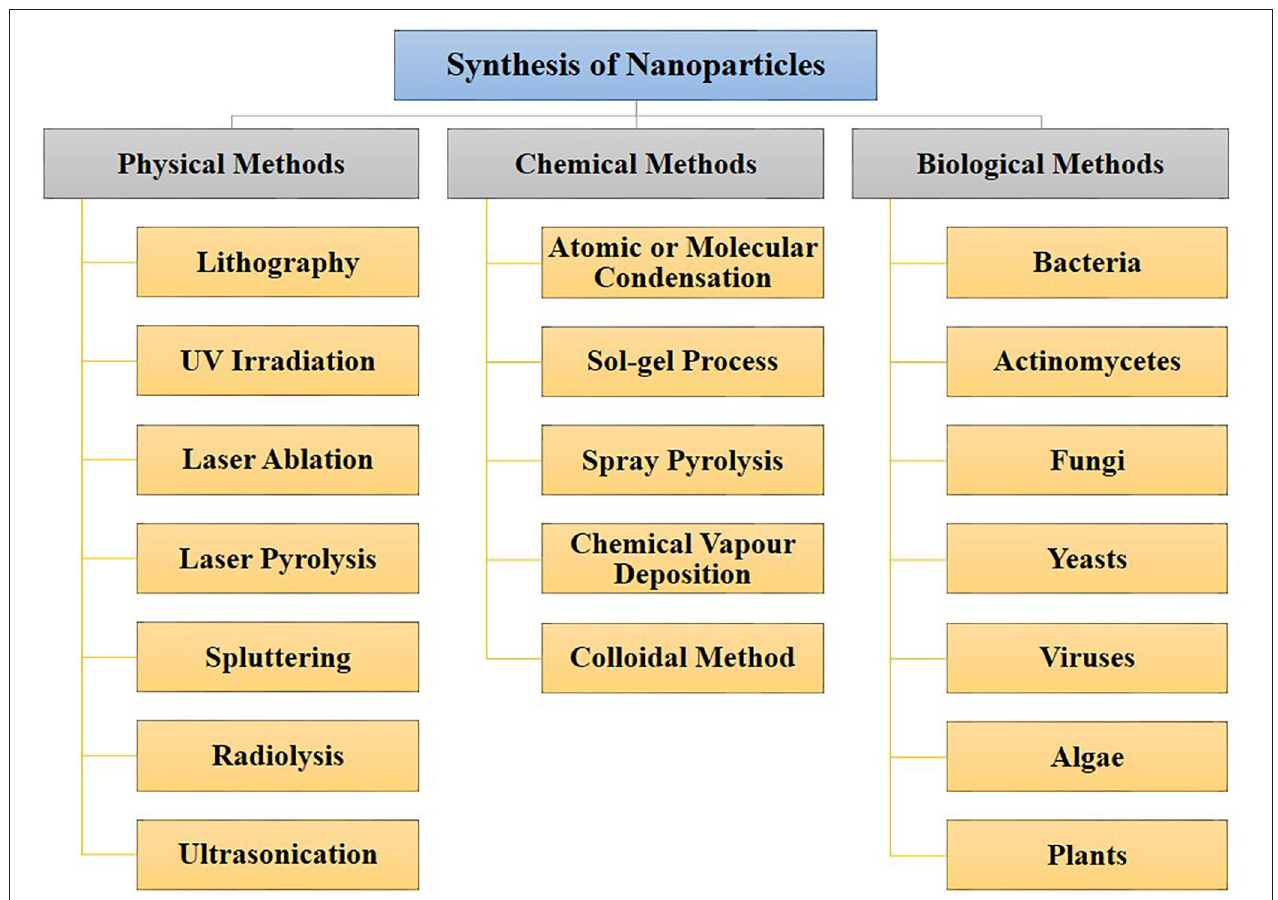
FIGURE 1 | Different approaches for nanoparticles synthesis. Nanoparticles can be synthesized through physical, chemical, and biological